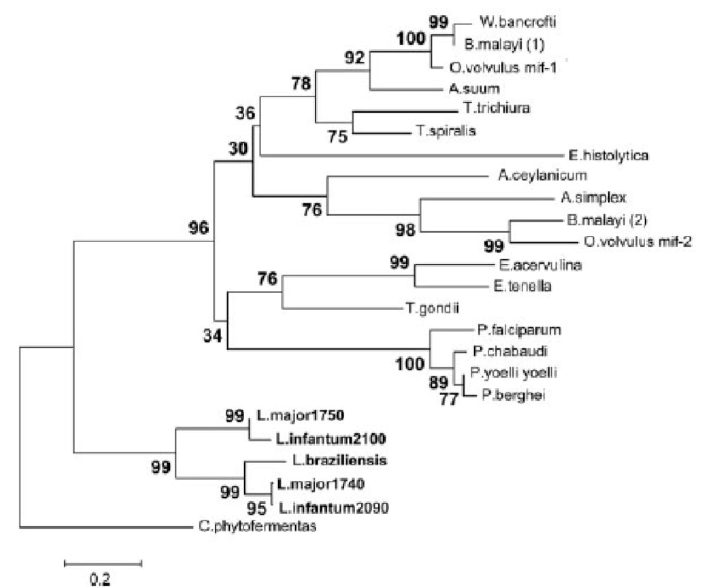
Figure 2. Phylogram of parasitic MIF protein sequences including five MIF-like proteins identified in the Leishmania species L. major , L. infantum , and L. braziliensis . The percentage of replicate trees in which the associated taxa clustered together in a bootstrap test are represented next to the branches. The evolutionary distances represented in the units of the number of amino acid substitutions per site as computed using the Poisson correction method. Taken from Kamir et al. 2008 [30].